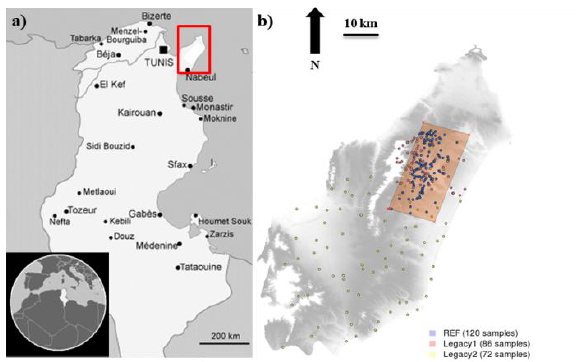
Figure 1: a) Location of the study area in the Northern Tunisia (Red rectangle), b) Hyperspectral image area (orange rectangle), 120 soil samples of the REF database (blue), 86 soil samples collected in 2000 including the Focused-Legacy database (pink) and 72 soil samples collected between 1973 and 1979 including the No-Focused-Legacy database (yellow) plotted over a DEM of the Cap Bon.